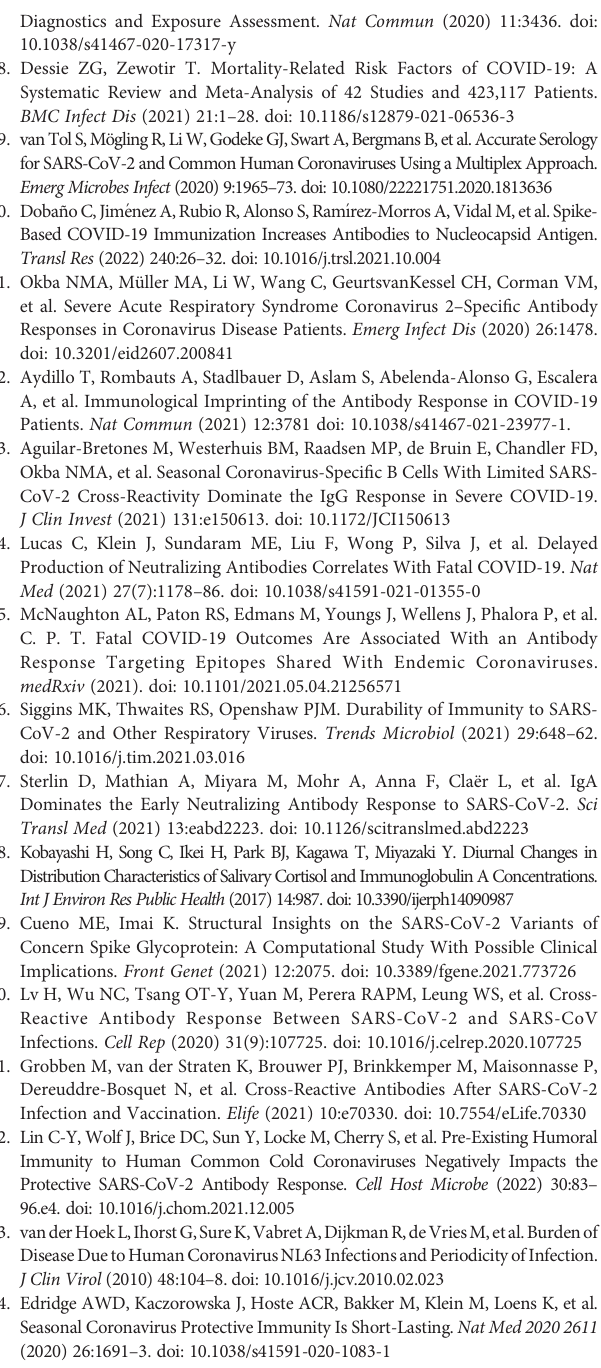
monomeric S1 subunits of human coronaviruses measured by protein microarray in sera from pulmonary ward with moderate disease (yellow box) and ICU with severe disease(redbox)COVID-19patients.Mediantitersarepresented(minandmaxvalue). Supplementary Figure 4 | IgG antibody responses in patients with non-fatal and fatal disease. IgG titers were measured against recombinant trimeric spike proteins and monomeric S1 subunits of human coronaviruses by protein microarray in sera from acutelyillpatientsoftheICUwithnon-fatalandfataldisease.Dataarerepresentedasthe median value (min and max value), signi fi cance (Mann-Whitney U test) *P <